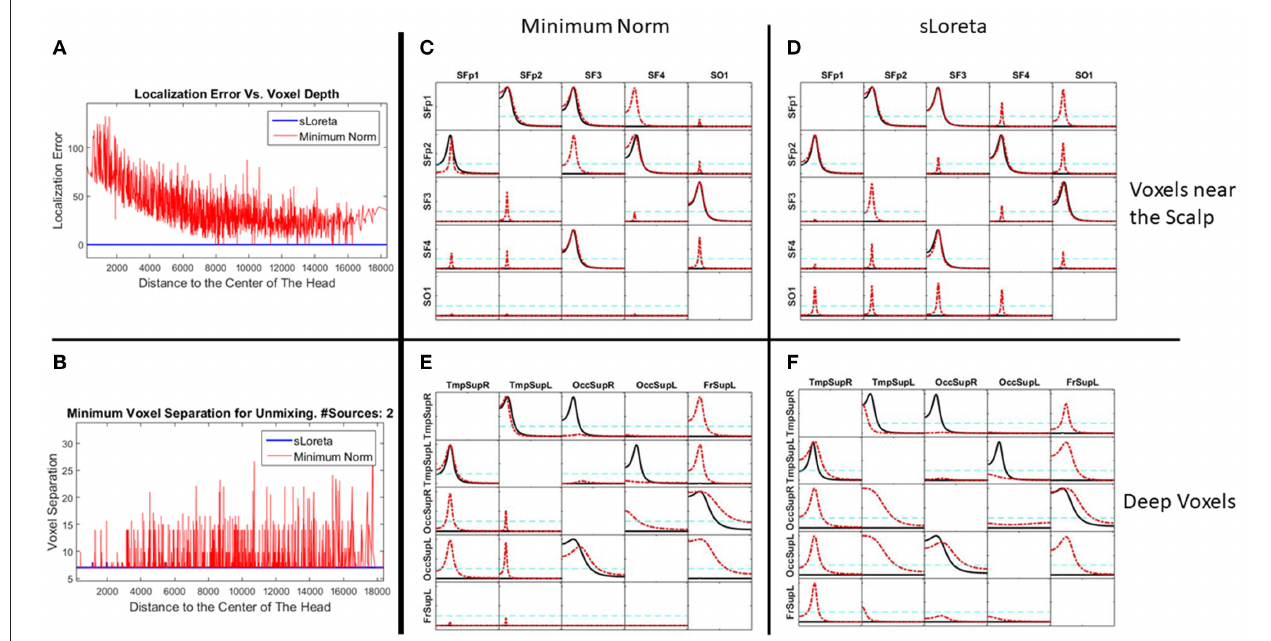
FIGURE 5 | Performance of the unmixing procedure for the Minimum Norm and sLoreta, for voxels at different depth in the brain. Panels (A,B) show a comparison of MNE and sLoreta in terms of localization error and resolution matrix. Panels (C–F) show the connectivity patterns for a set of voxels near the scalp (C,D) and a set of voxels deeper in the brain (E,F) for MNE (C,E) and sLoreta (D,F) . The reconstruction of the causality after unmixing is perfect in all situations.